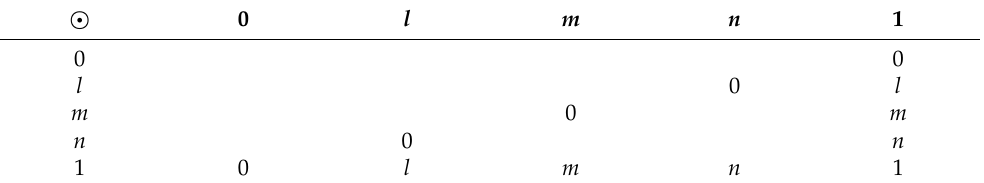
Figure 2. Lattice order relation on L . Table 4. The partial operation (cid:12)